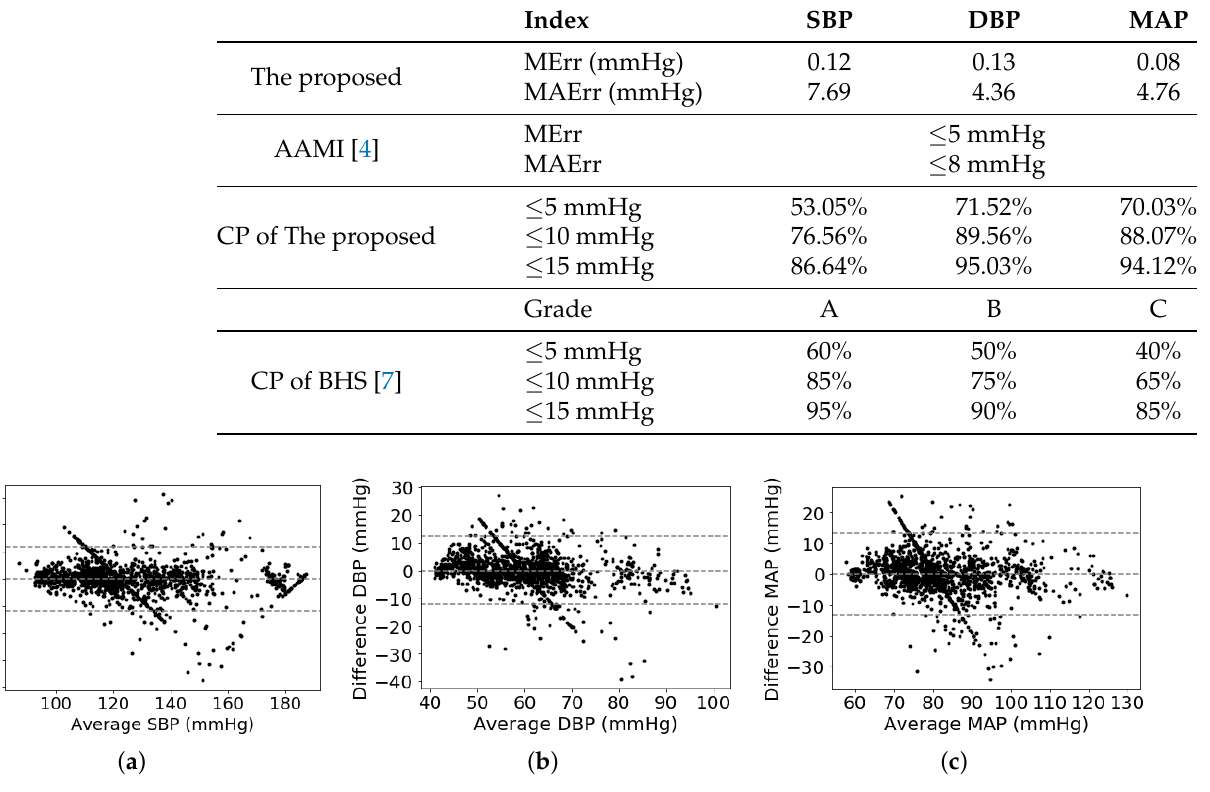
Table 2. Estimation Performance of The Proposed Method.